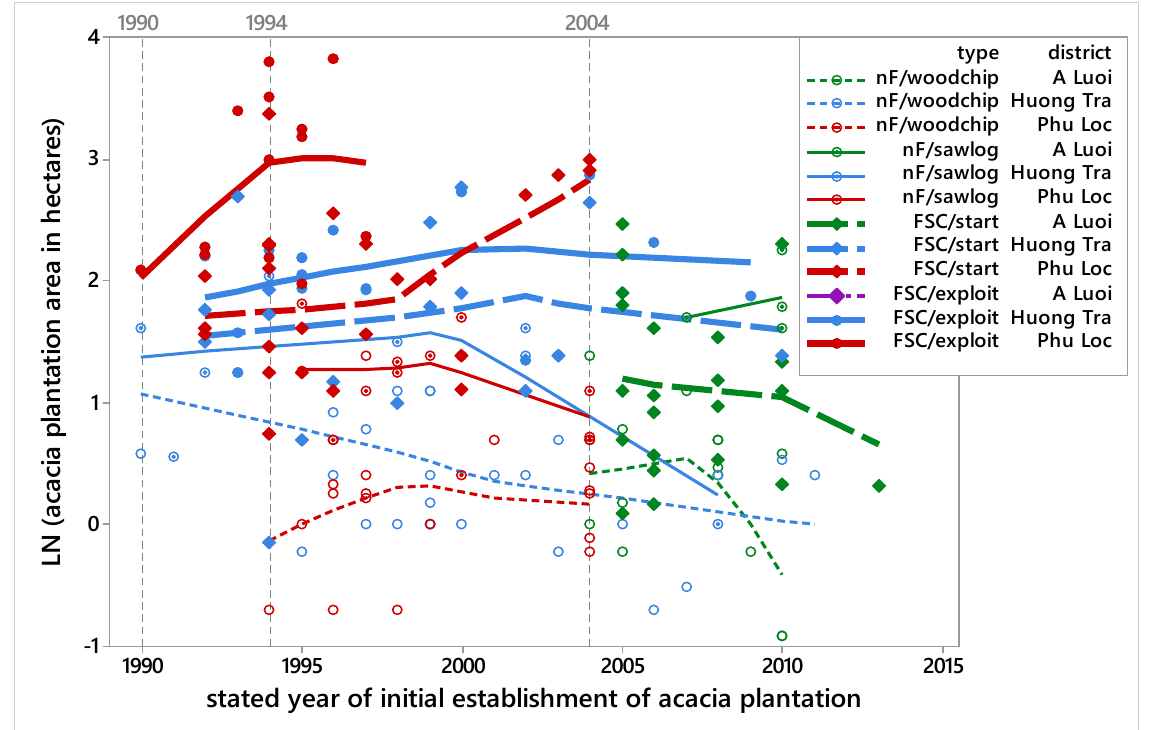
Figure 4. Tree farmers’ plantation land assets (by tree farmer type and district) set in relation to the time when the farmers set up their first plantations. The lines indicate a LOWESS smoother fit (smoothing degree 0.5, steps 2). All data from farmer interviews.